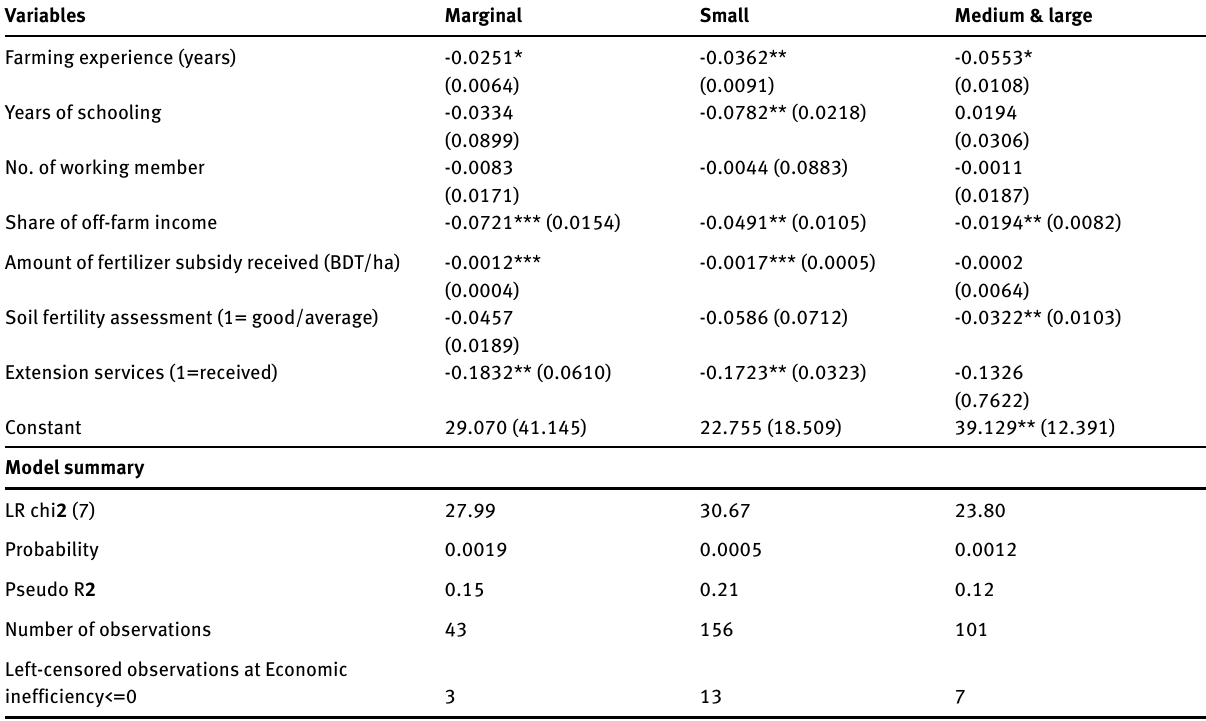
Table 4: Maximum likelihood estimates for factors explaining efficiency differentials among farms (Tobit estimation results)